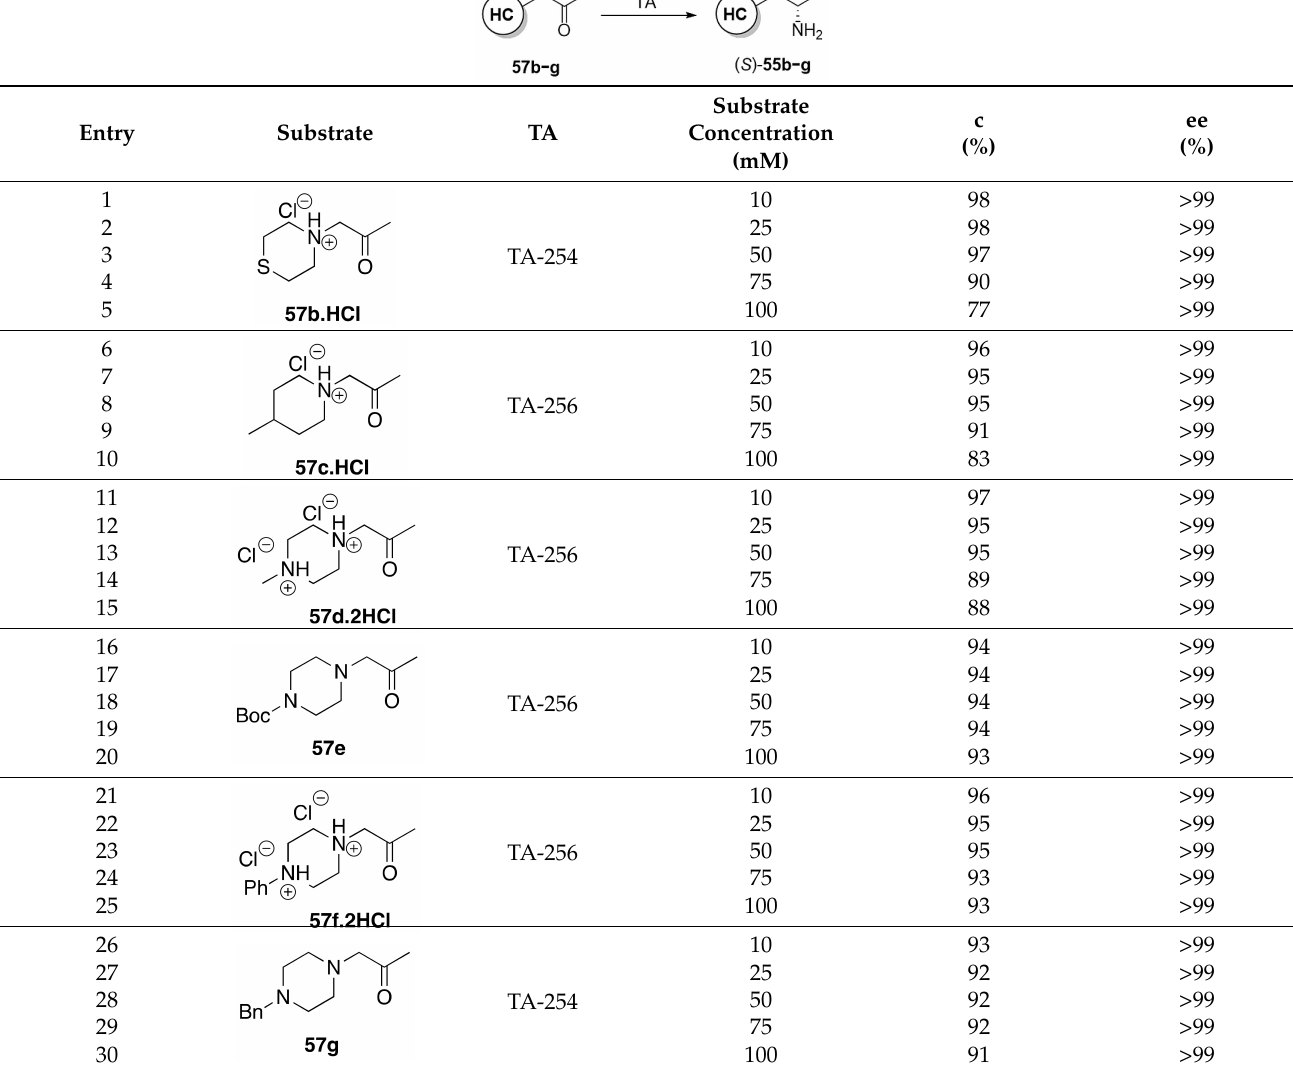
Table 3. Asymmetric transamination of the heterocyclic ketones 57b–g with the best performing ( S )-selective